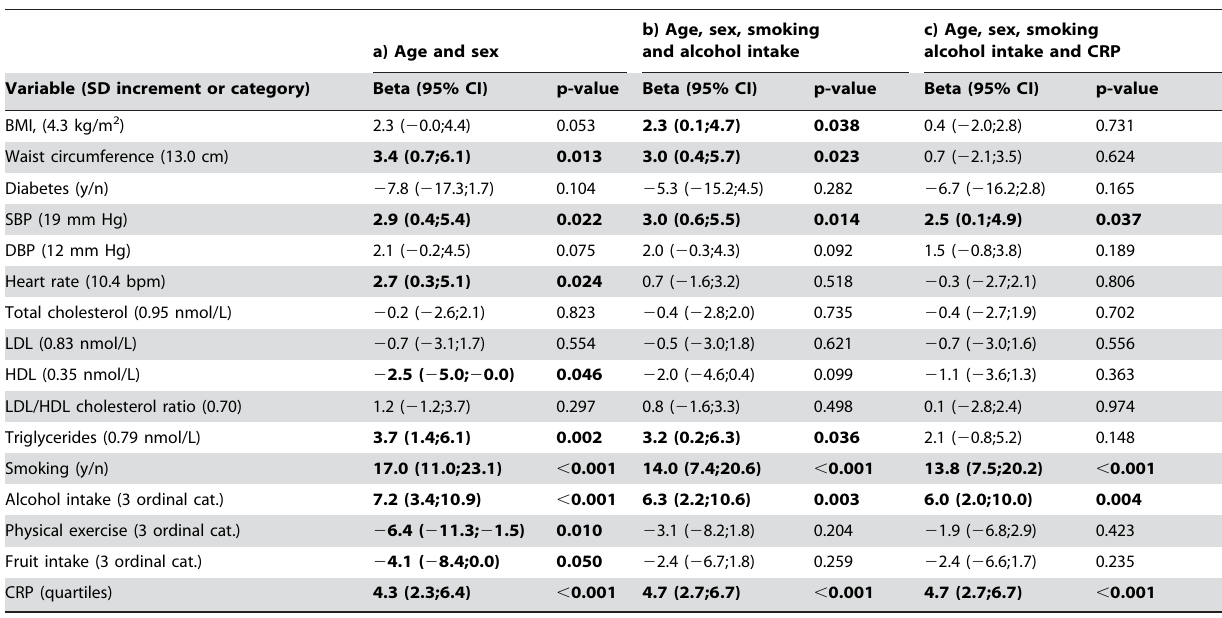
Table 2. Linear regressions for MMP-9 as dependent